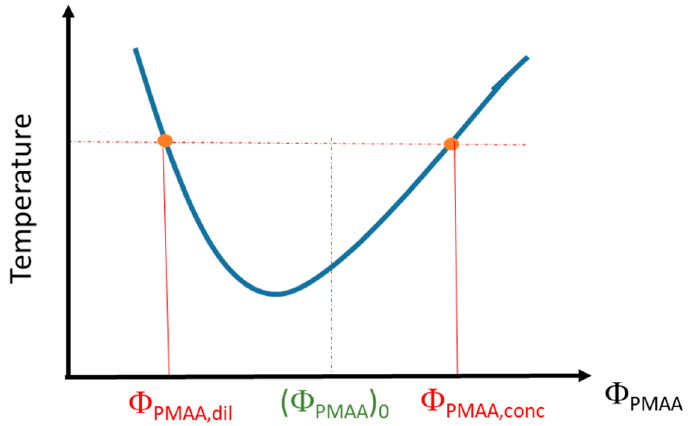
Figure 1. Scheme of the phase diagram determination from the binodal curve.